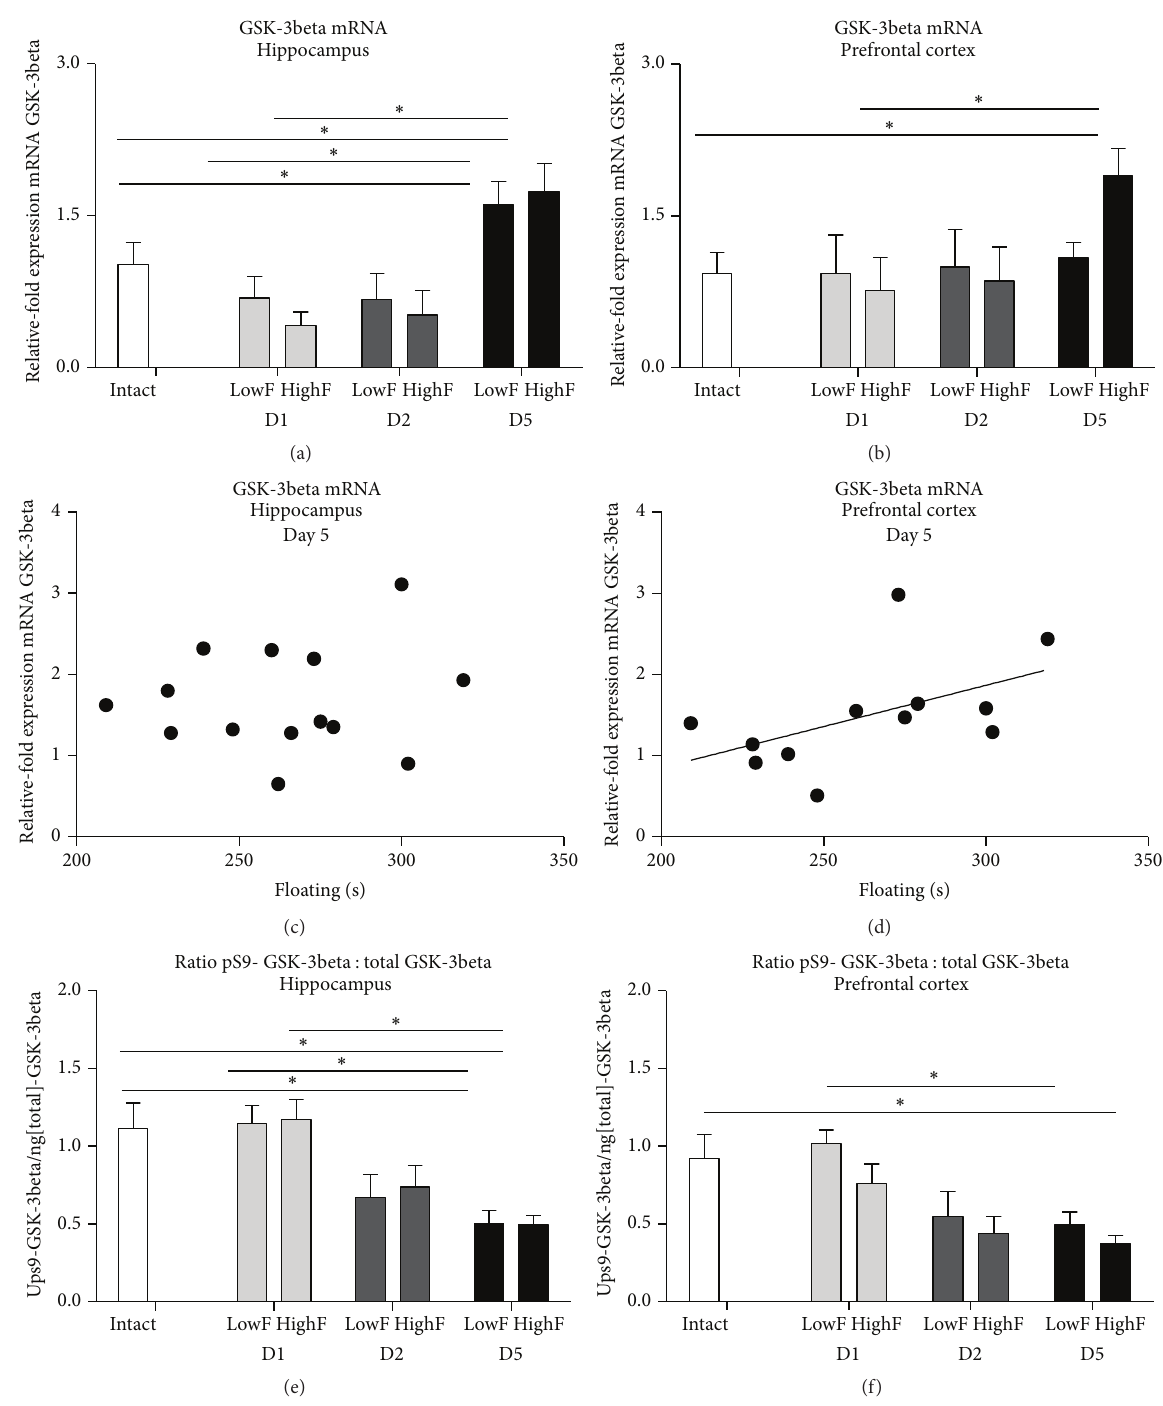
Figure 5: Brain activities of GSK-3beta in “high”- and “low-floaters” in the modified swim test. Mice were assigned to subgroups with “high-” ( 𝑛 = 7 ) or “low-” floaters ( 𝑛 = 7 ) using a mean of the groups as a criterion of a group formation. In comparison to intact controls, GSK-3beta mRNA (a) in the hippocampus and (b) in the prefrontal cortex was not significantly changed in either subgroup of mice on Day 1, Day 2, and Day 5 of swim test. (c) Hippocampal levels of GSK-3beta mRNA ( 𝑛 = 14 ) did not correlate with total duration of floating on Day 5 of swim test. (d) The levels of GSK-3beta mRNA in prefrontal cortex ( 𝑛 = 14 ) significantly correlated with the total duration of floating on Day 5 of a swim test. (e) In comparison to intact controls, hippocampal ratio of pS9 GSK-3beta /total GSK-3beta was significantly decreased both in “low” and “high” floating mice on Day 5, but not on Day 1 and Day 2. (f) In comparison to intact mice, the ratio of pS9 GSK-3beta /total GSK-3beta in prefrontal cortex was not significantly changed on Day 5 of swim test; size of groups as indicated above. ∗ 𝑝 < 0.05 , ANOVA and Tukey’s multiple comparisons test; see the text; LowF: subgroup of mice classified as “low-floaters”; HighF: subgroup of mice